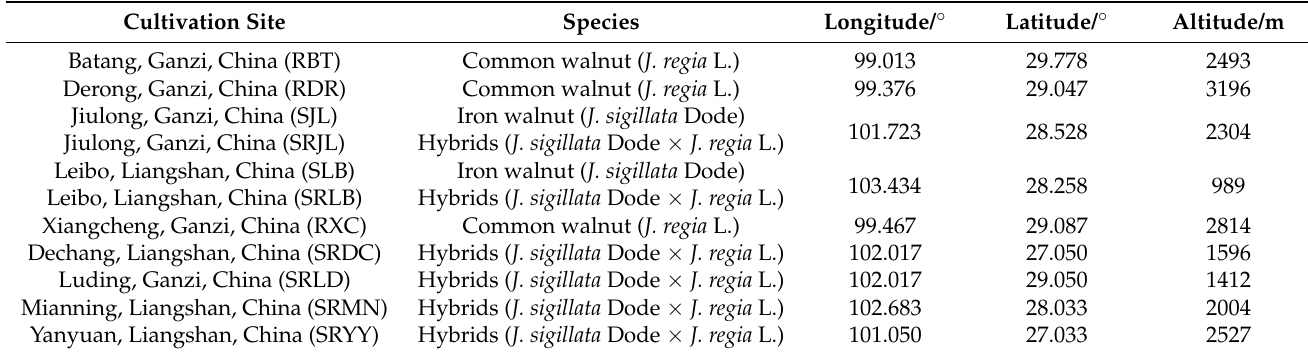
Table 1. Geographic site and cultivated species/genotypes of the walnut